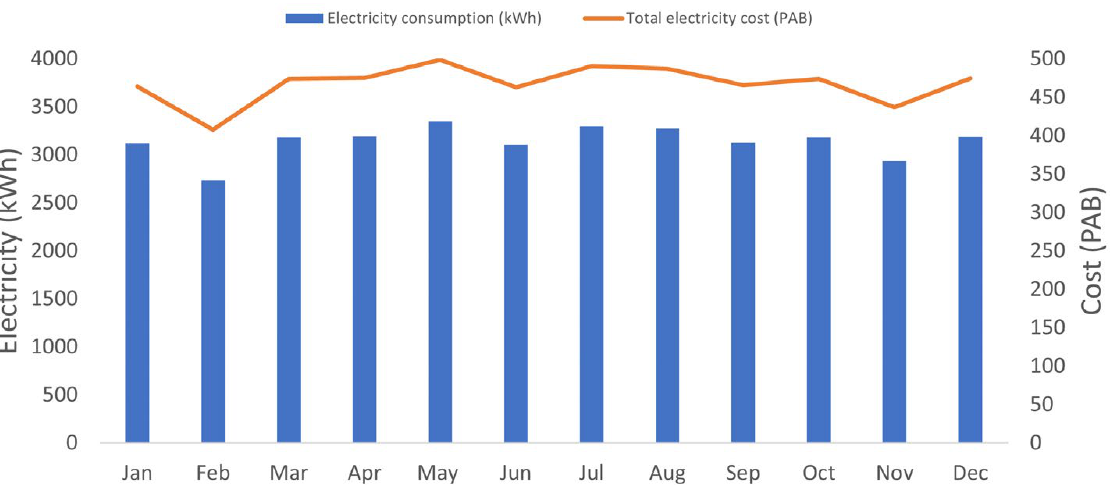
Figure 9. Comparison between electricity consumption and cost of electricity consumption of the optimized urbanization in a year. Table 8. Optimal solutions selected for the case study.